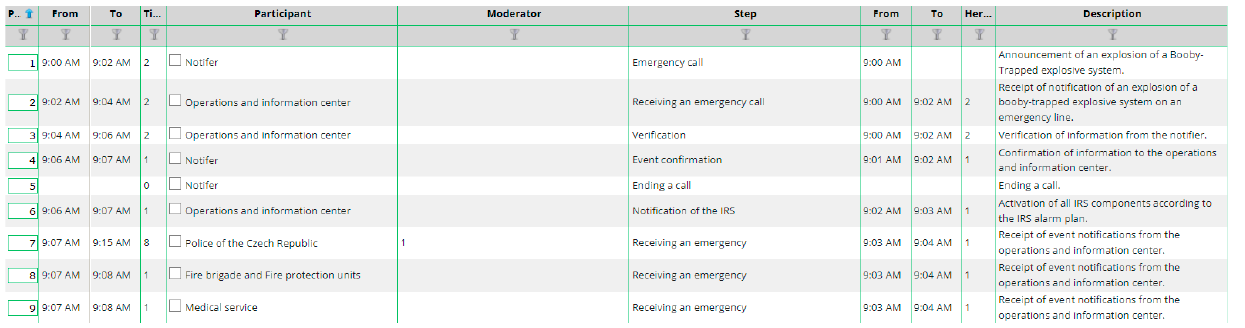
Figure 5. Overview of